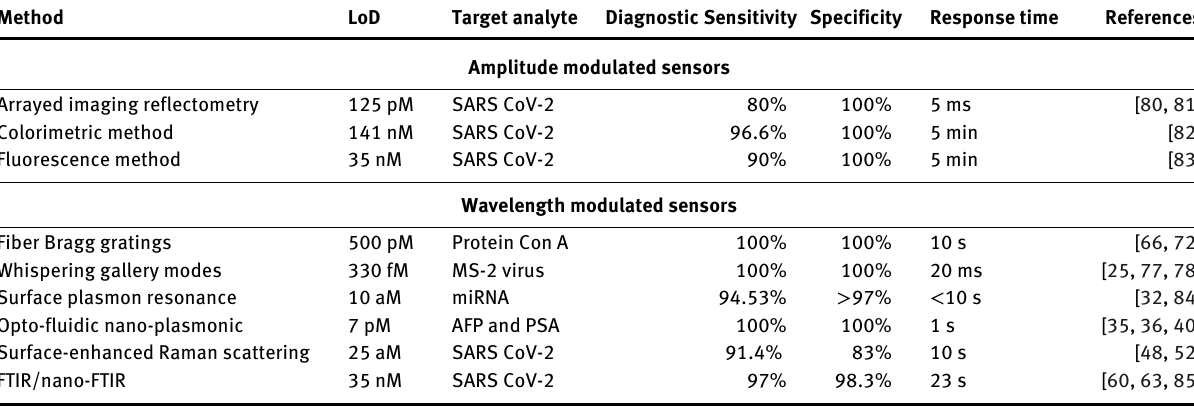
Table 1: Performance of various optical diagnostic technologies for virus detection. Method LoD Target